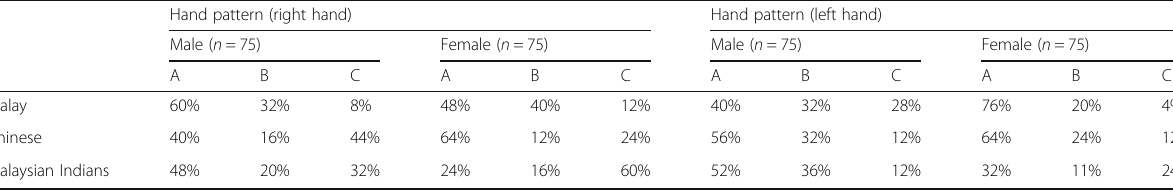
Table 1 Table showing the percentage distribution of hand patterns among the three races based on gender Hand pattern (right